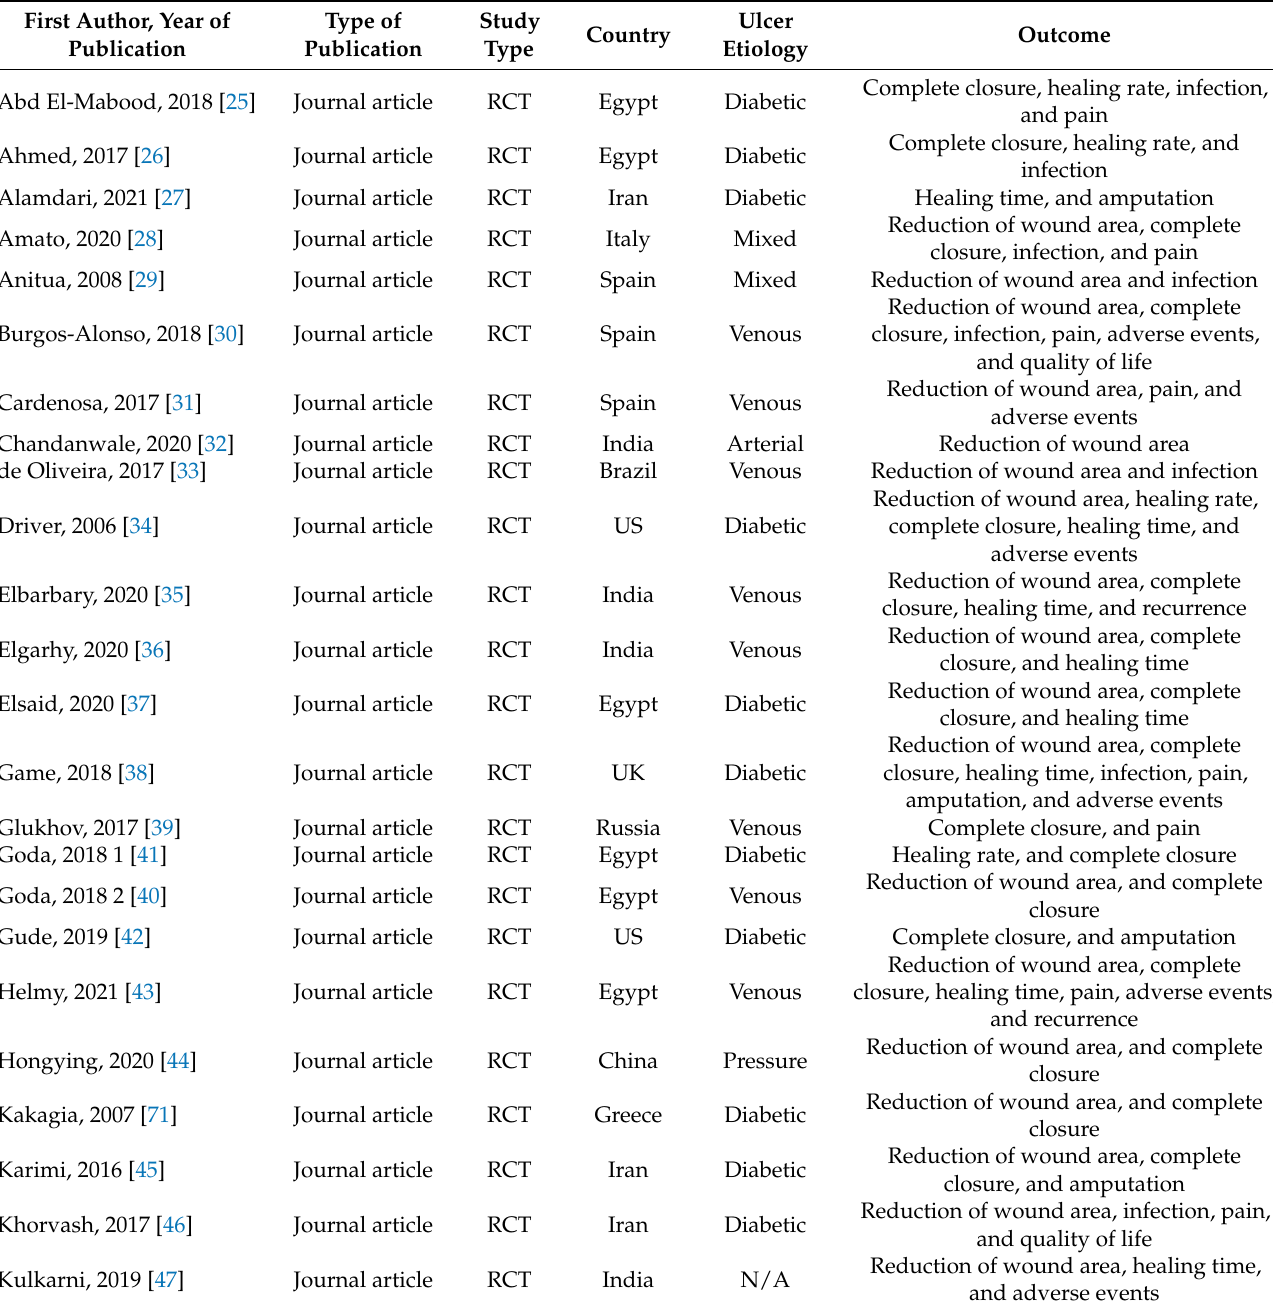
Table 1. Characteristics of the included